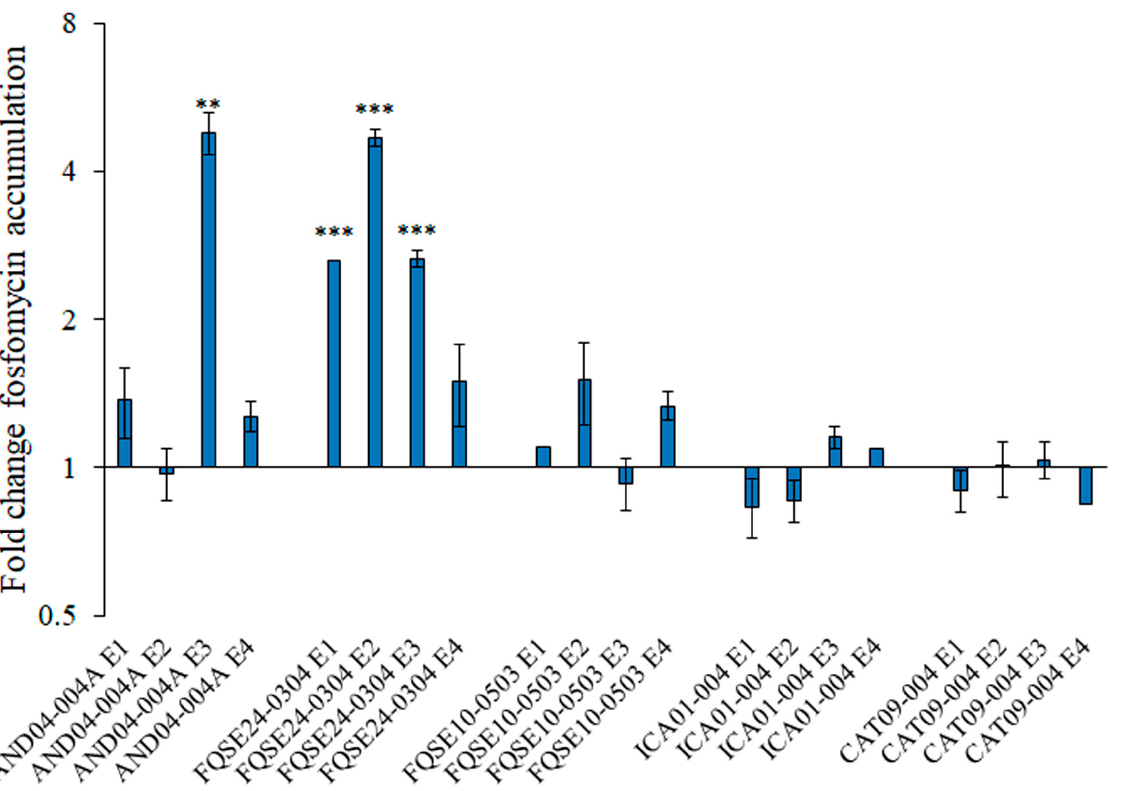
Figure 3. Intracellular active fosfomycin accumulation in populations evolved in the presence of tobramycin from diverse P. aeruginosa clinical strains. Fold change of the amount of accumulated active fosfomycin per CFU after incubation of bacteria with 2 mg/mL of the antibiotic in replicate populations evolved in the presence of tobramycin from AND04-004A, FQSE24-0304, FQSE10-0503, ICA01-004 and CAT09-004 strains respect to their respective control—evolved in the absence of antibiotic—populations is represented. The amount of active intracellular fosfomycin is estimated regarding the hallo produced by a disk soaked with the intracellular content of the tested population in a plate seeded with E. coli OmniMAX TM . Error bars indicate standard deviations of the results from three biological replicates. Statistically significant differences were calculated with t -test for paired samples assuming equal variances: ** p < 0.005, *** p < 0.0005.